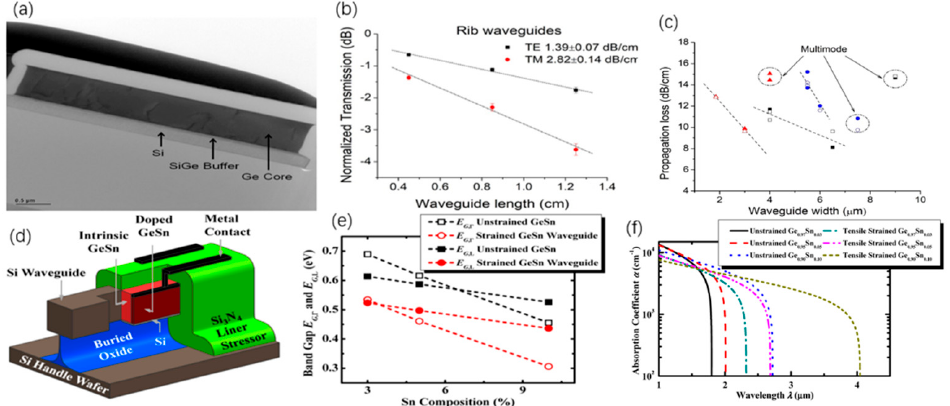
Figure 22. ( a ) Cross-sectional view of Ge-on-SOI microscope. ( b ) The normalized transmission of rib waveguide varies with waveguide length. ( c ) The relationship between the transmission loss and length of the waveguide [309]. Copyright 2018 IOP Publishing Ltd. ( d ) Structure diagram of stretch- able GeSn waveguide. ( e ) Band gap change of GeSn in relaxed and stretched states. ( f ) Absorption spectrum when the content of Sn in GeSn changes [308]. Copyright 2015 The Optical Society.